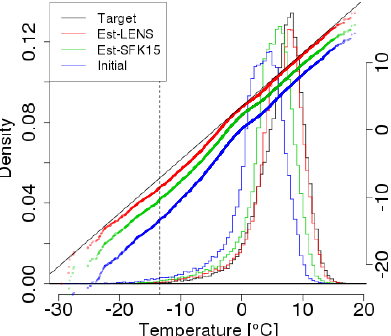
Figure 9. Comparisons between actual and projected LENS data for winter (DJF) using a model fit from the LENS data (red) and using a model fit from the SFK15 ensemble (green) near Seattle. The projected data are obtained by using 40 simulations of the time period 1979–2016 (viz. “Initial” shown in blue) projected 80 years into the future, 2059–2096. Both projection estimates are compared against the actual LENS model output during the same period, 2059–2096 (viz. “Target” shown in black). Corresponding qq-plots are juxtaposed using the same horizontal axis. The dashed vertical line represents the . 01 quantile in the initial observations. LENS estimates are, not surprisingly, closer to the target than the SFK15 estimates since the LENS quantile map uses the LENS data while the SFK15 estimate does not involve the LENS data in building its quantile